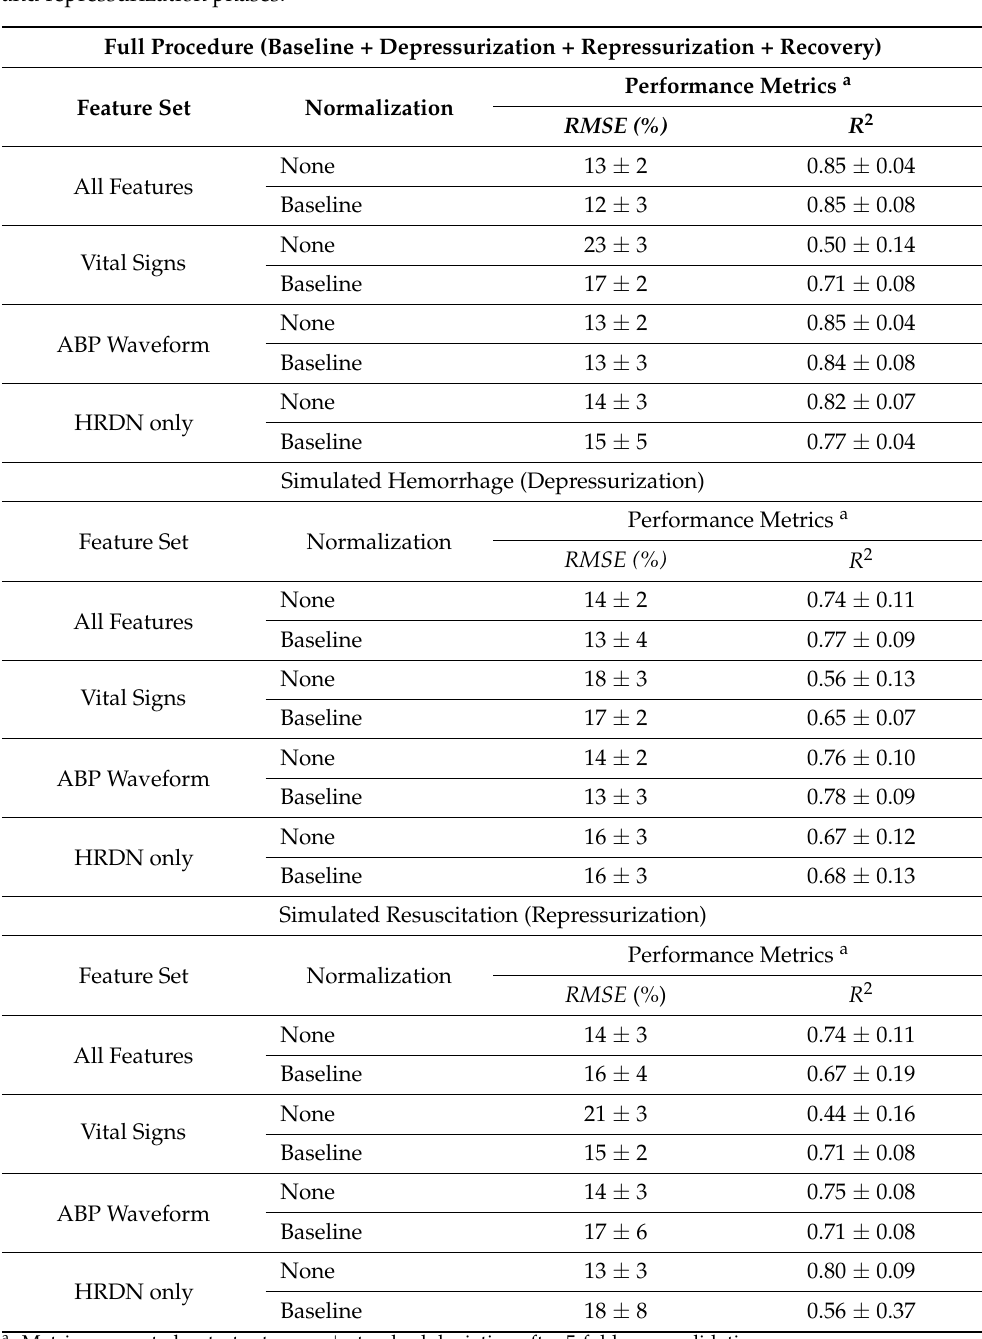
Table 3. CRM estimation results for cross-validation training and testing for the GB-tree model on the full data set (includes the baseline, depressurization, repressurization, and recovery phases from each experiment as shown in Figure 1), followed by training and testing on only the depressurization and repressurization